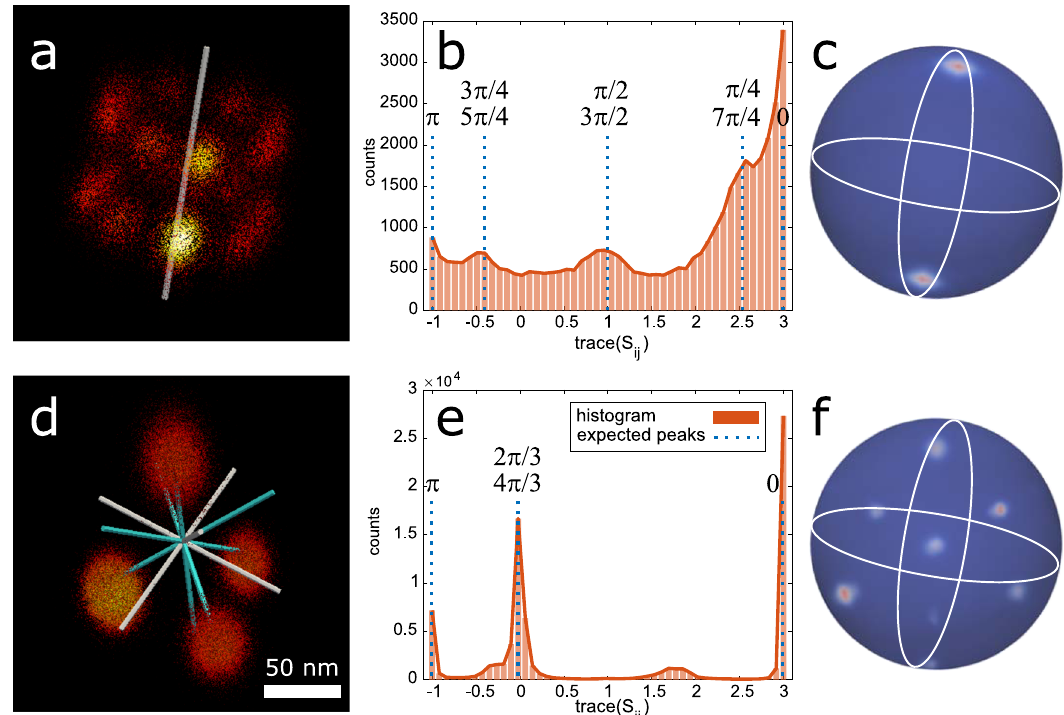
Fig. 3 Symmetry group detection from SMLM data. a Fusion of 300 STORM Nup96 particles and the estimated rotational symmetry axis. b Histogram of the trace( S ij ) reveals the 8-fold rotational symmetry of the Nup96 protein. c Density plot of the estimated axes of rotation on the unit sphere for the Nup96 dataset. d Fusion of 400 3D PAINT DNA-origami tetrahedron particles and the estimated axes of rotation. The white and cyan bars indicate the 3-fold and 2-fold rotational symmetry axes, respectively. e Histogram of the trace( S ij ) reveals the 3- and 2-fold rotational symmetries of the tetrahedron structure. f Density plot of the estimated axes of rotation on the unit sphere. The dense regions on the unit sphere in c , f project the orientation of the estimated axis (es) of